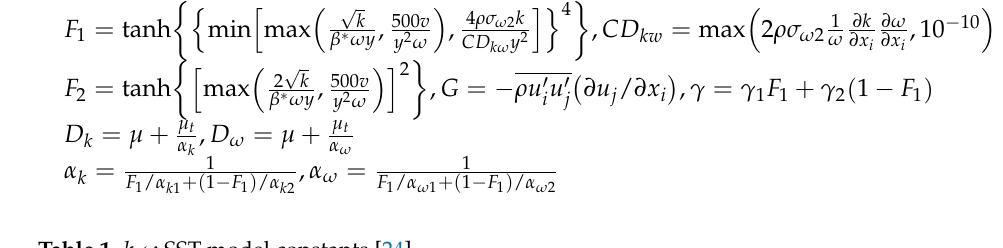
Table 1. k- ω SST model constants